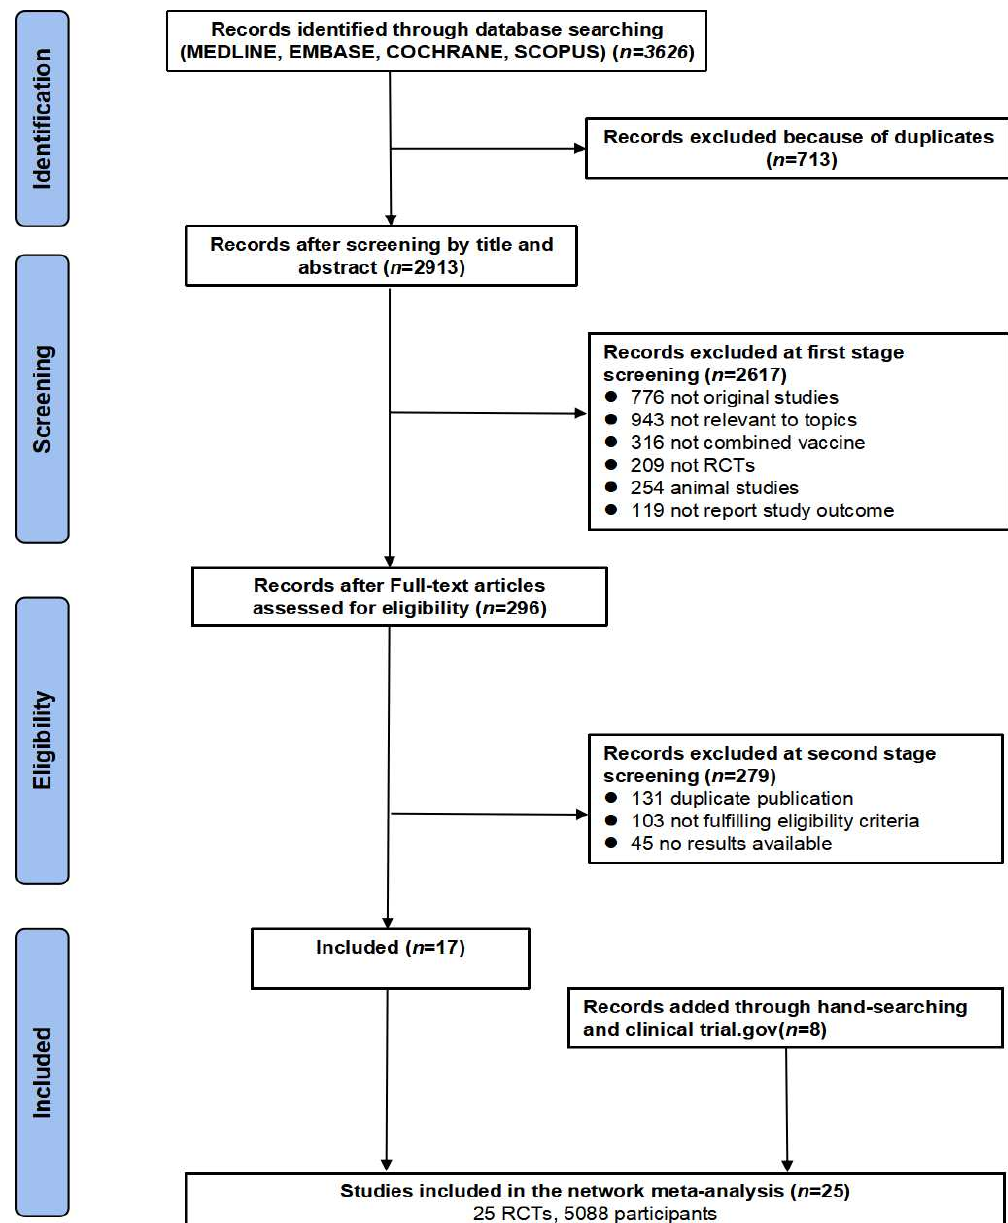
Figure 1. PRISMA flow diagram of study selection process